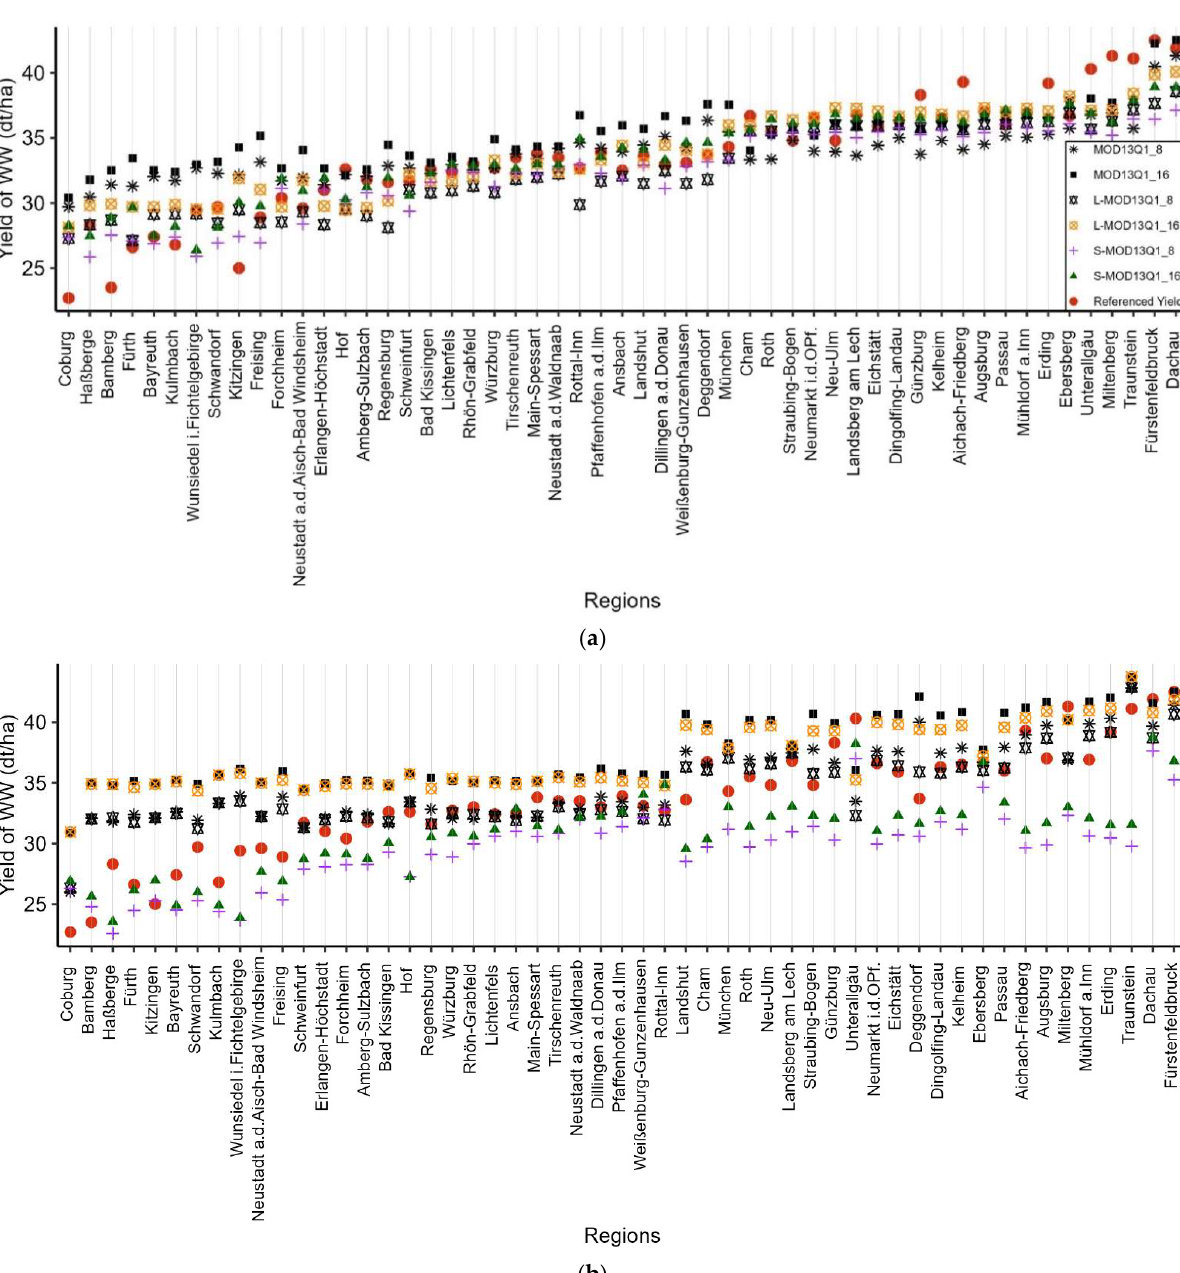
Figure 12. Spatial distribution of referenced yields and predicted yields for OSR using MOD13Q1 (8 and 16 days), L-MOD13Q1 (8 and 16 days), and S-MOD13Q1 (8 and 16 days) with LUE and WOFOST models for the state of Bavaria. The white colour represents no data available. A detailed map of the administrative regions of Bavaria is shown in Figure A1.